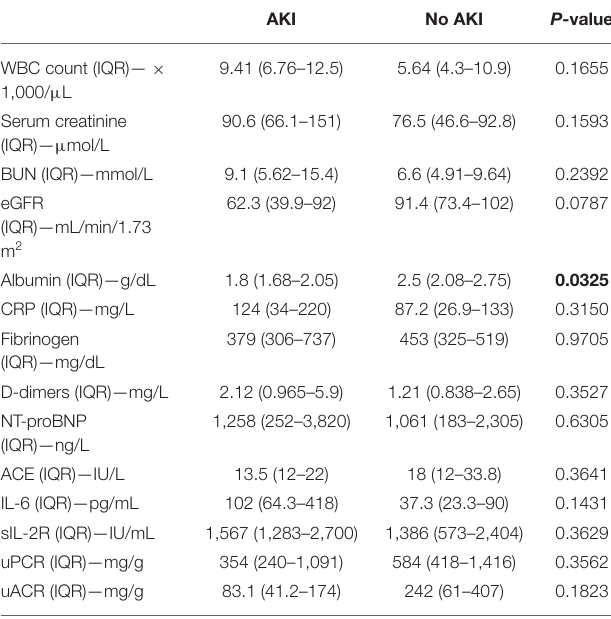
TABLE 3 | Association between AKI in COVID-19 and laboratory findings at time of ICU admission.